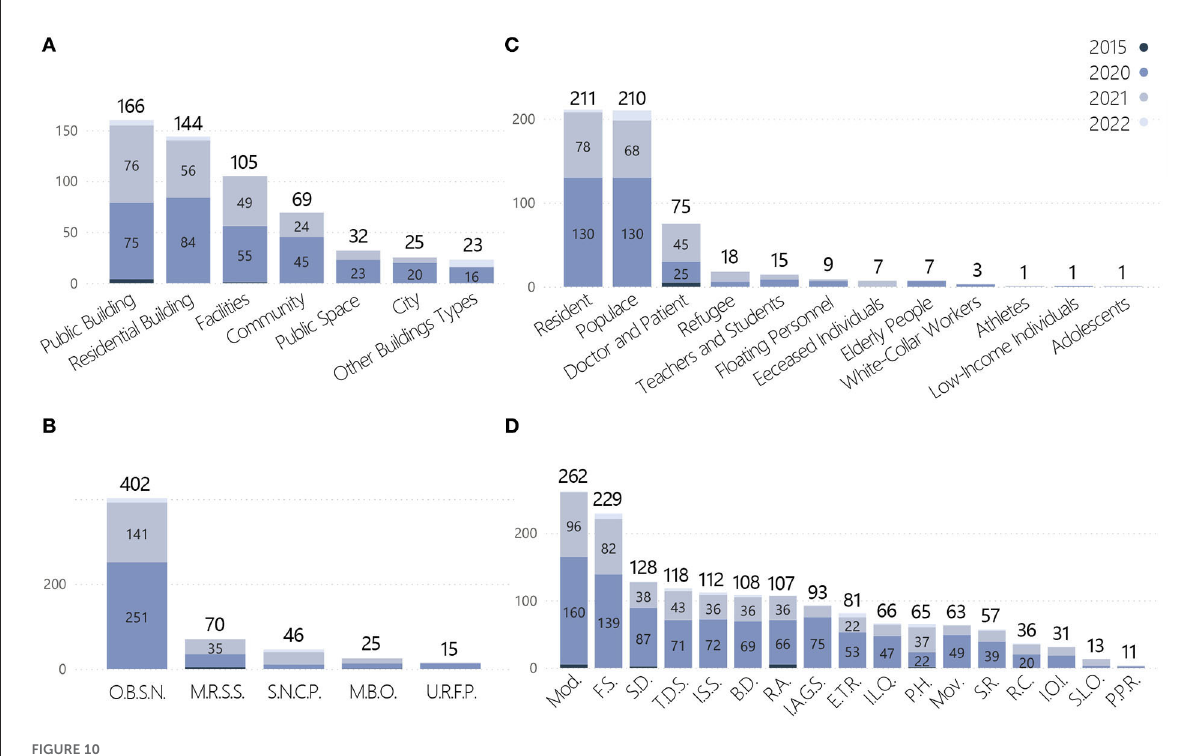
FIGURE10 Cross-tabulation results with year. (A) Year and architecture category. (B) Year and target problem. (C) Year and target group. (D) Year and strategies.